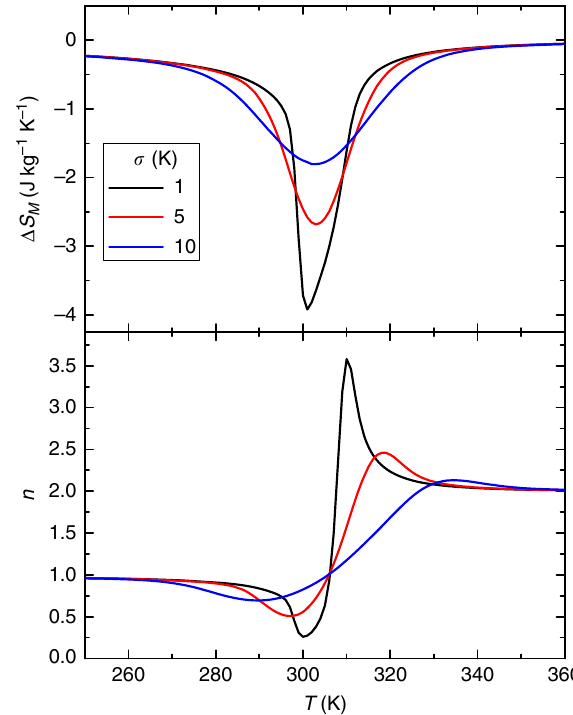
Fig. 9 Simulations with a Gaussian distribution of transition temperatures. Three different σ values of the Gaussian distribution of transition temperatures in the Bean and Rodbell model for η = 1.5 at maximum fi eld of 2.25 T were used. Despite the smooth appearance of the magnetic entropy change (upper panel), which does not resemble FOPT, the overshoot of n > 2 near the transition is observed in all cases (lower panel)